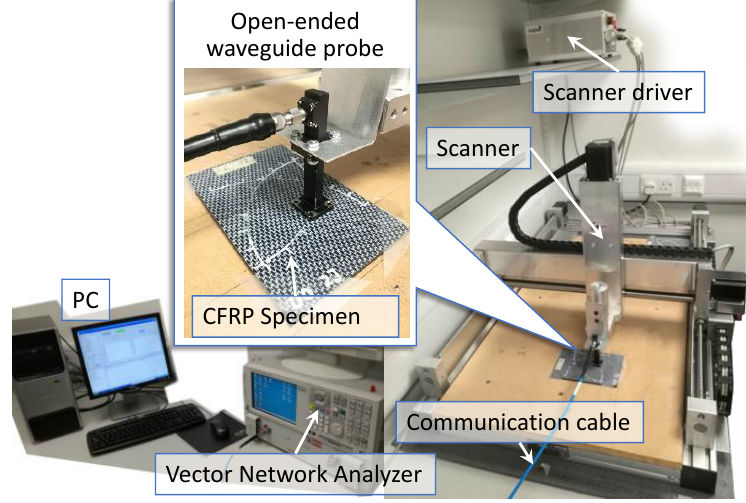
Figure 7. Experimental setups for light impact damage detection on CFRPs.